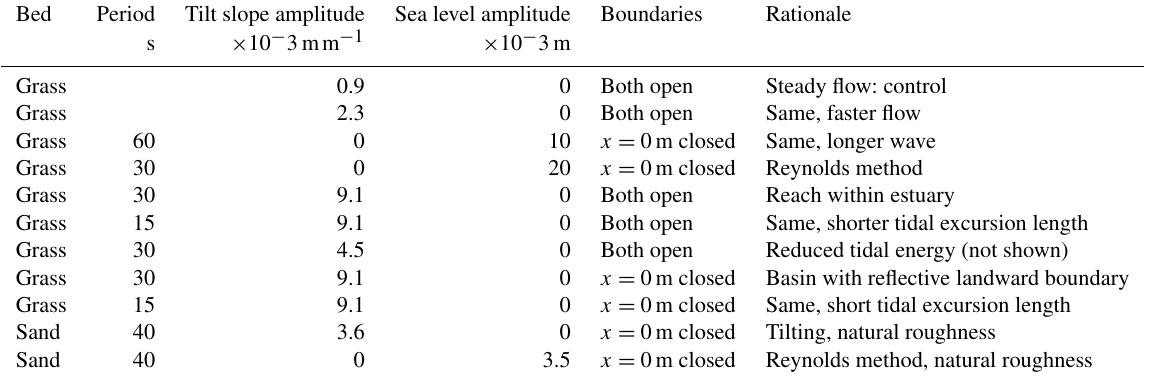
Table 1. Boundary conditions applied in all experiments: auxiliary fixed-slope experiments to determine the roughness of the artificial grass bed, periodic tilting experiments with one or two open boundaries and periodic sea level variations. Experiments with sand beds were conducted with a shallow sea of 2m length to reduce boundary effects and were closed on the upstream